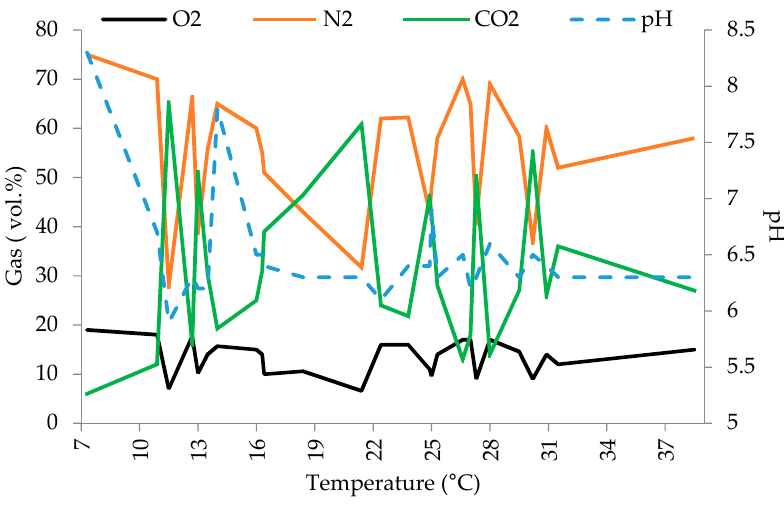
Figure 5. Gas composition of groundwatersfrom the Choygan springs.